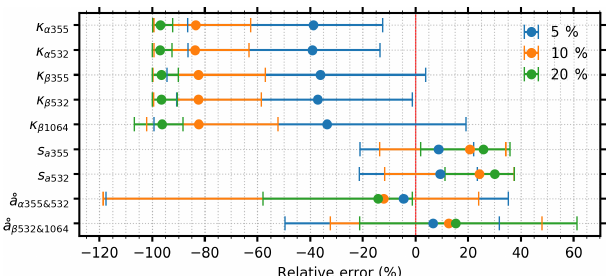
Figure 8. Relative errors in fitted and calculated parameters with 10% random errors for backscatter and extinction and 5% (blue), 10% (orange), and 20% (green) random error for relative humidity. The dots are the median values, and the error bars denote the 5th and 95th percentiles. The dashed red line marks the position of